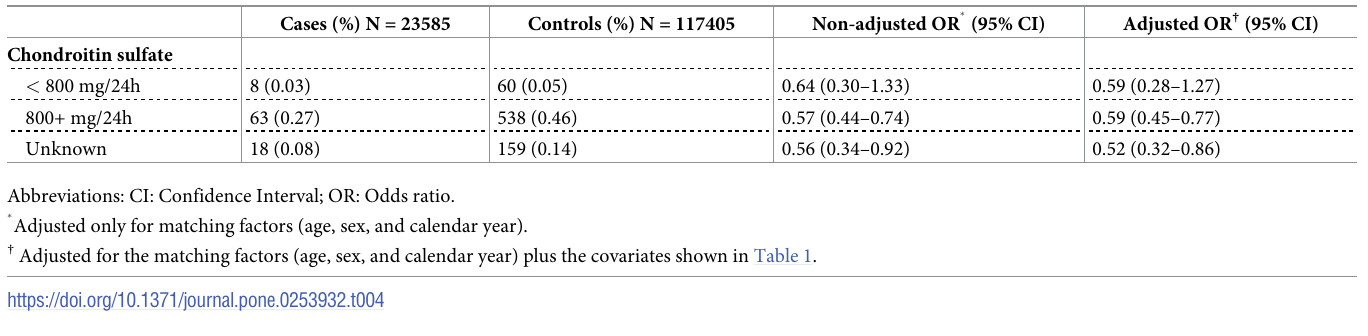
Table 4. Risk of AMI associated with the current use of chondroitin sulfate as compared to non-use according to daily